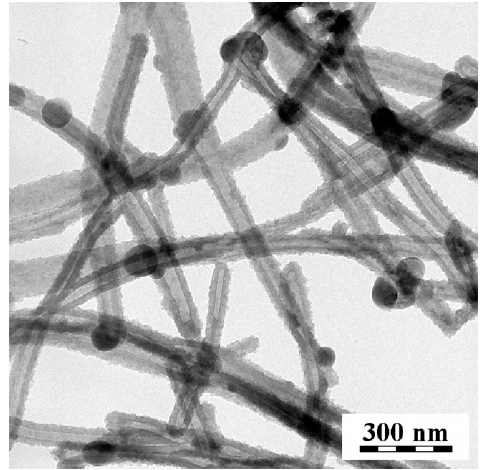
Figure 2. Illustration of nanotubular morphology by transmission electron microscopy.